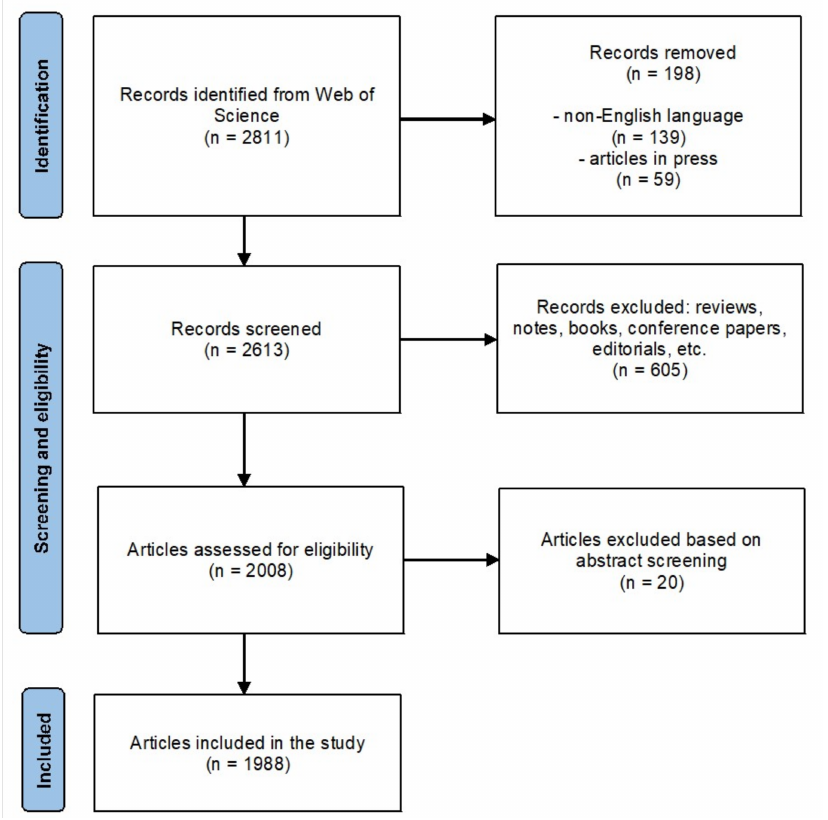
Figure 1. PRISMA flow